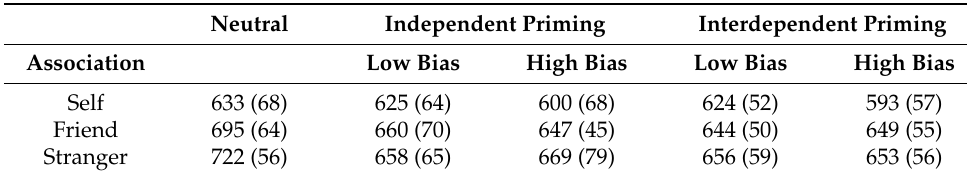
Table 1. Mean RTs (ms) and SDs (in brackets) for match trials as a function of association, priming, and bias group in Experiment 1.